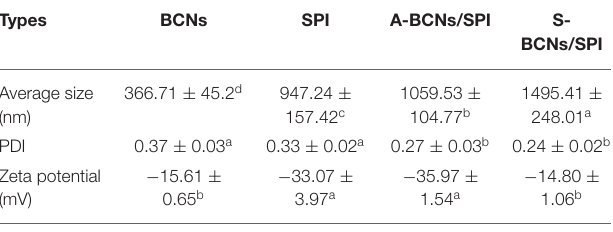
TABLE 1 | Average size, polydispersity index (PDI), and zeta- ( ζ -) potential of bacterial cellulose nanofibers (BCNs), soy protein isolate (SPI), and BCNs/SPI colloidal particles with different self-assembly